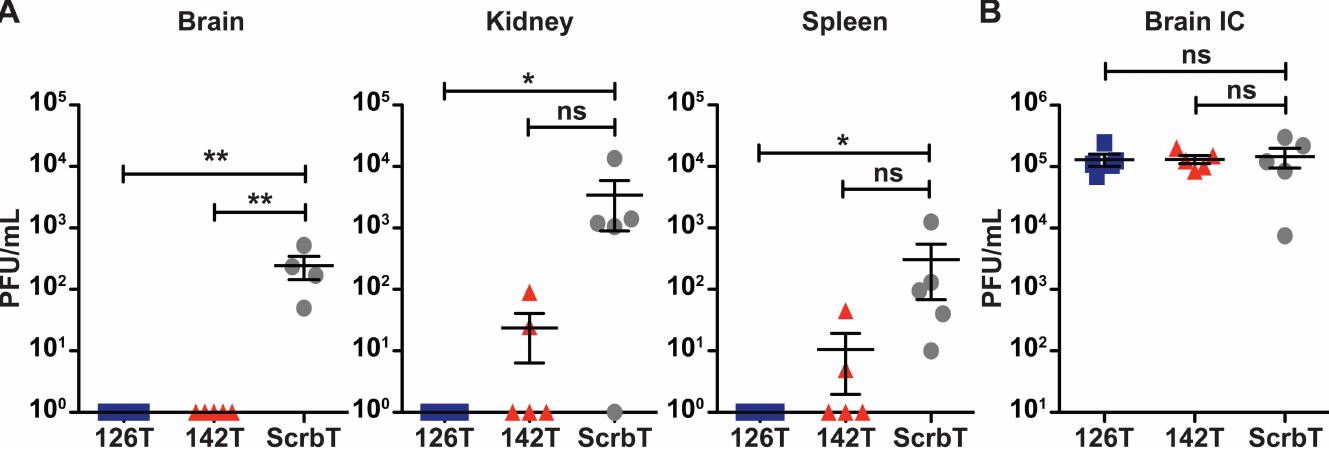
Fig 5. Endothelial cell infection induced damage is necessaryfor extrapulmonary spread of H5N1 virus. (A) Viral titers in different organs. C57BL/6J mice (n = 5) were intranasallyinfected with 25 PFU of the H5N1 viruses and on day 8 pi, different organswere harvestedfor viral titer determination. Each data point represents an individual mouse (PFU/mL). (B) Viral replicationin the brain upon intracerebellarinjection. C57BL/6Jmice (n = 3–5) were injected with 100 PFU of the H5N1 viruses in the cerebellum and on day 3 pi whole brainswere isolatedfor viral titer determination.Each data point represents the viral titer of an individualmouse (PFU/mL; mean ± SEM). The limit of detectionis 10 PFU/mL. Asterisk denotesstatistical significancedetermined by one- way ANOVA and the values are denotedas * p < 0.05, ** p < 0.01, *** p < 0.001and ns–non significant.Data presented here is a representative of at least two independent